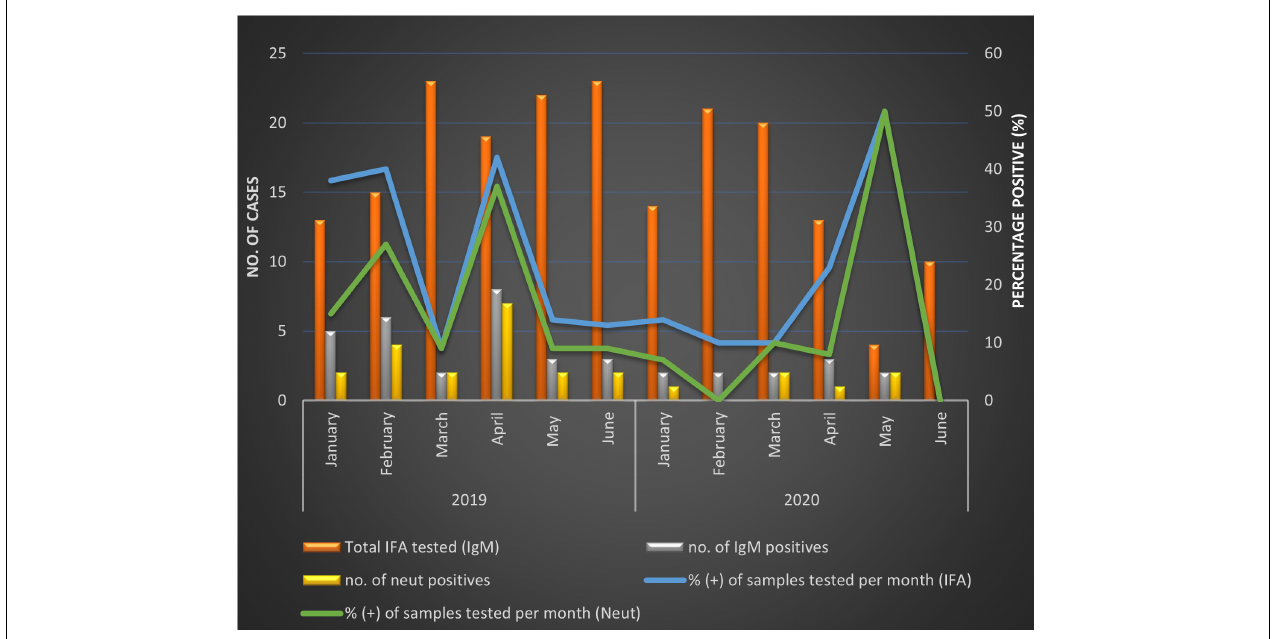
FIGURE 1 | Positivity rate calculated for SINV IgM-positive specimens from patients with acute febrile and neurological disease per month between January and June in 2019 and 2020,